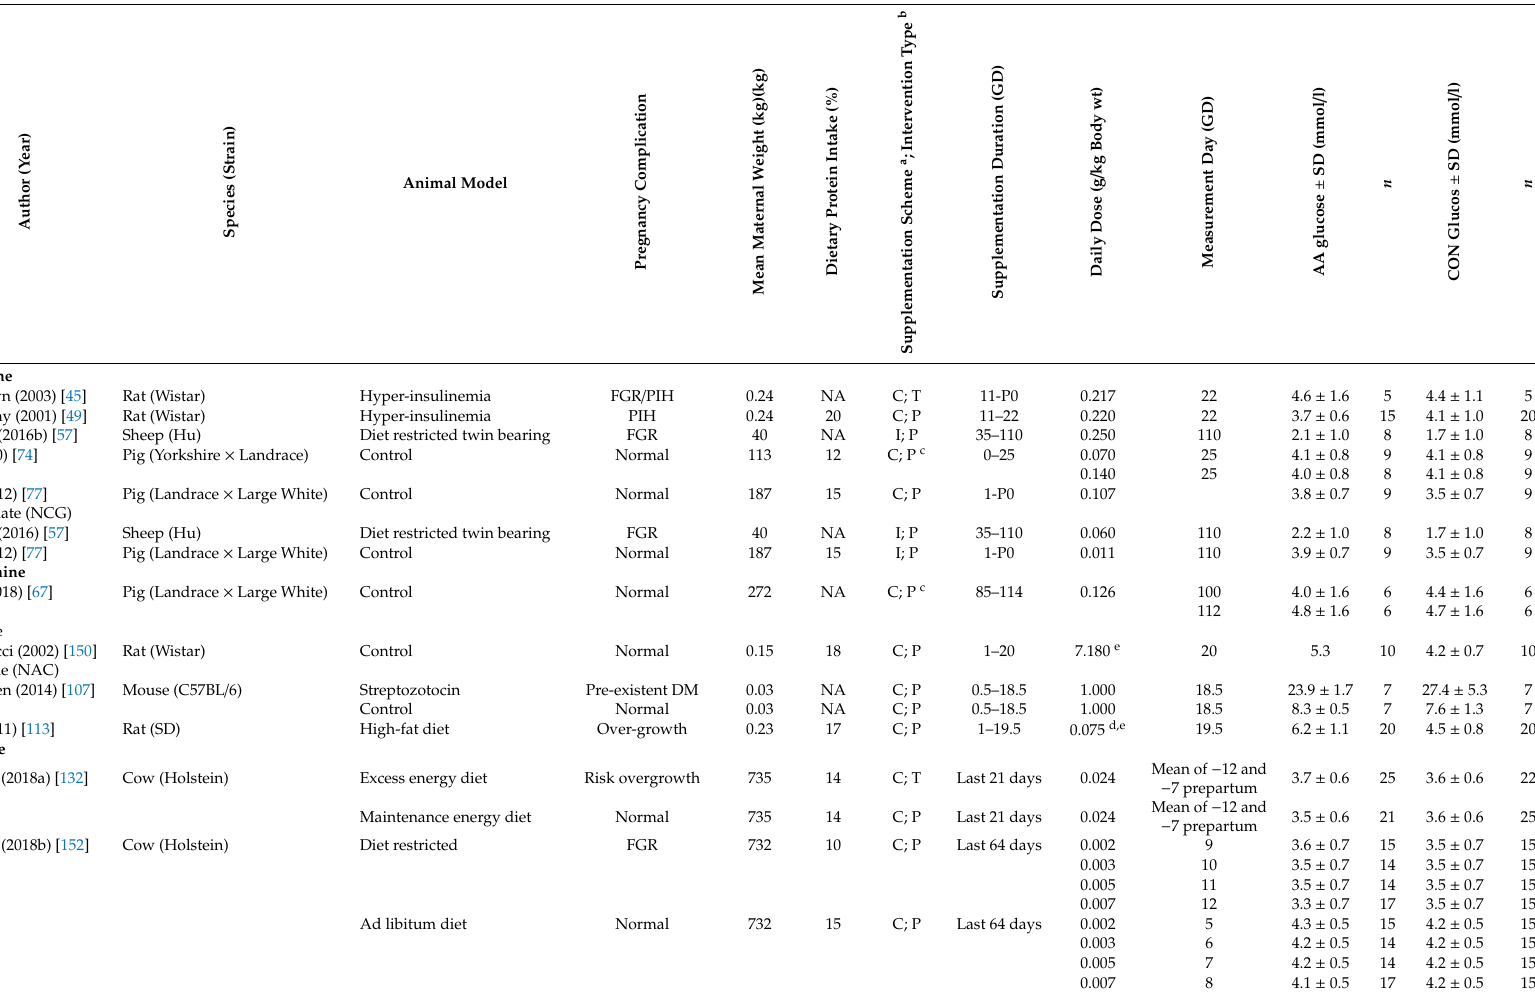
Table A9. Data extraction of included animal and human studies on maternal glucose